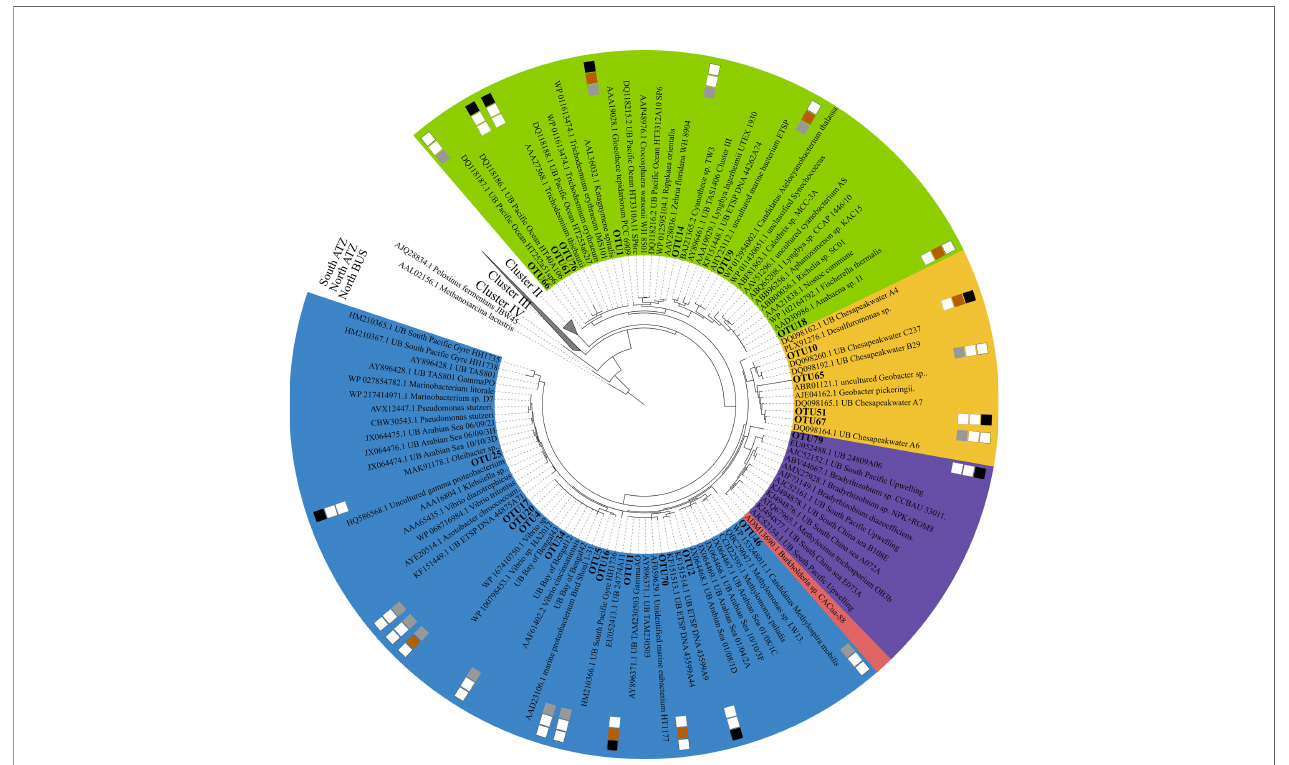
FIGURE 4 | Maximum likelihood tree of Cluster I nifH amino acid sequences. The phylogenetic tree is based on a Poisson model with 1000 bootstraps. OTUs are shown in bold nearest to their closest relative. Locations from where sequences were derived from are shown in the outer heatmap, fark brown represents the Northern Angola Tropical Zone, black indicates the Southern Angola Tropical Zone and grey indicates the Northern Benguela Upwelling Zone. Cyanobacteria are shown in green, gamma-proteobacteria are shown in blue, epsilon-proteobacteria are shown in yellow, alpha-proteobacteria are shown in red and beta- proteobacteria are shown in